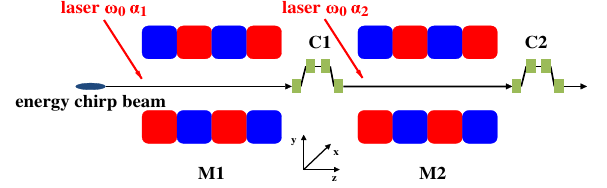
FIG. 1. Schematic layout for the generation of electron beams with a frequency-chirped density